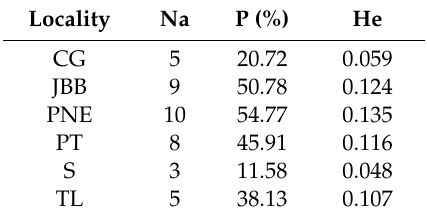
Table 2. Parameters of intrapopulation genetic diversity of Myrcia bella based on AFLP markers. Locality